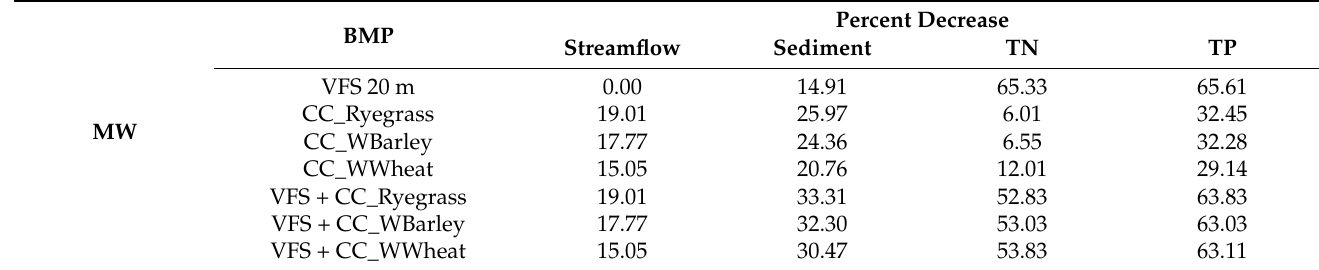
Table 4. Percentage reductions when different BMPs were implemented in MW.